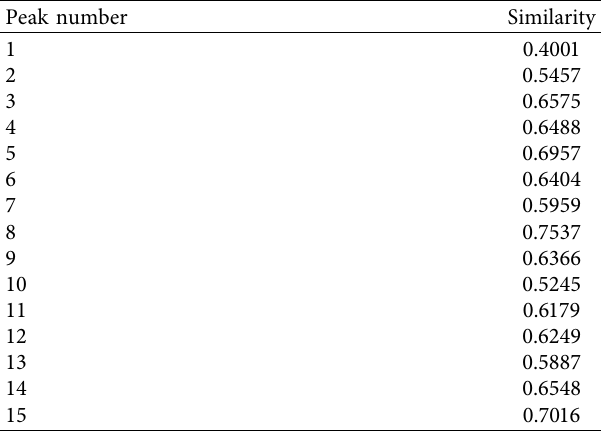
Table 8: Grey correlation between the common peaks of flavonoids from Glycyrrhiza uralensis Fisch. and xylene-induced ear swelling in